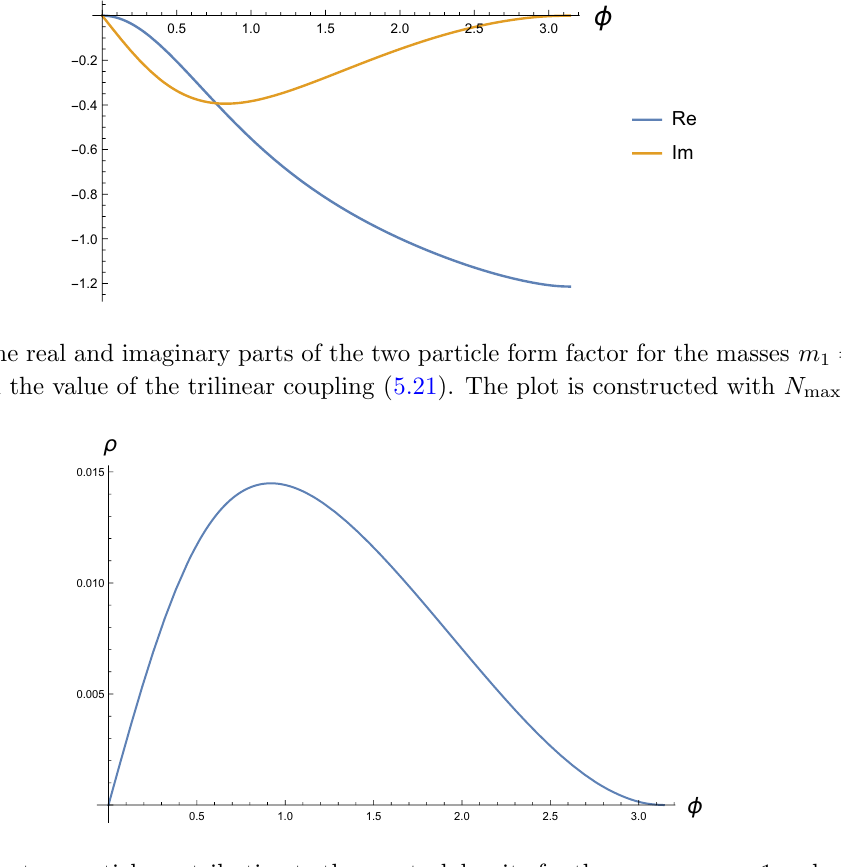
Figure 6 . The two particle contribution to the spectral density for the masses m 1 = 1 and m 2 = p 3 and the value of the trilinear coupling (5.21). The plot is constructed with N max = 50. These results are in a full agreement with the discussion of section 4.1, see in